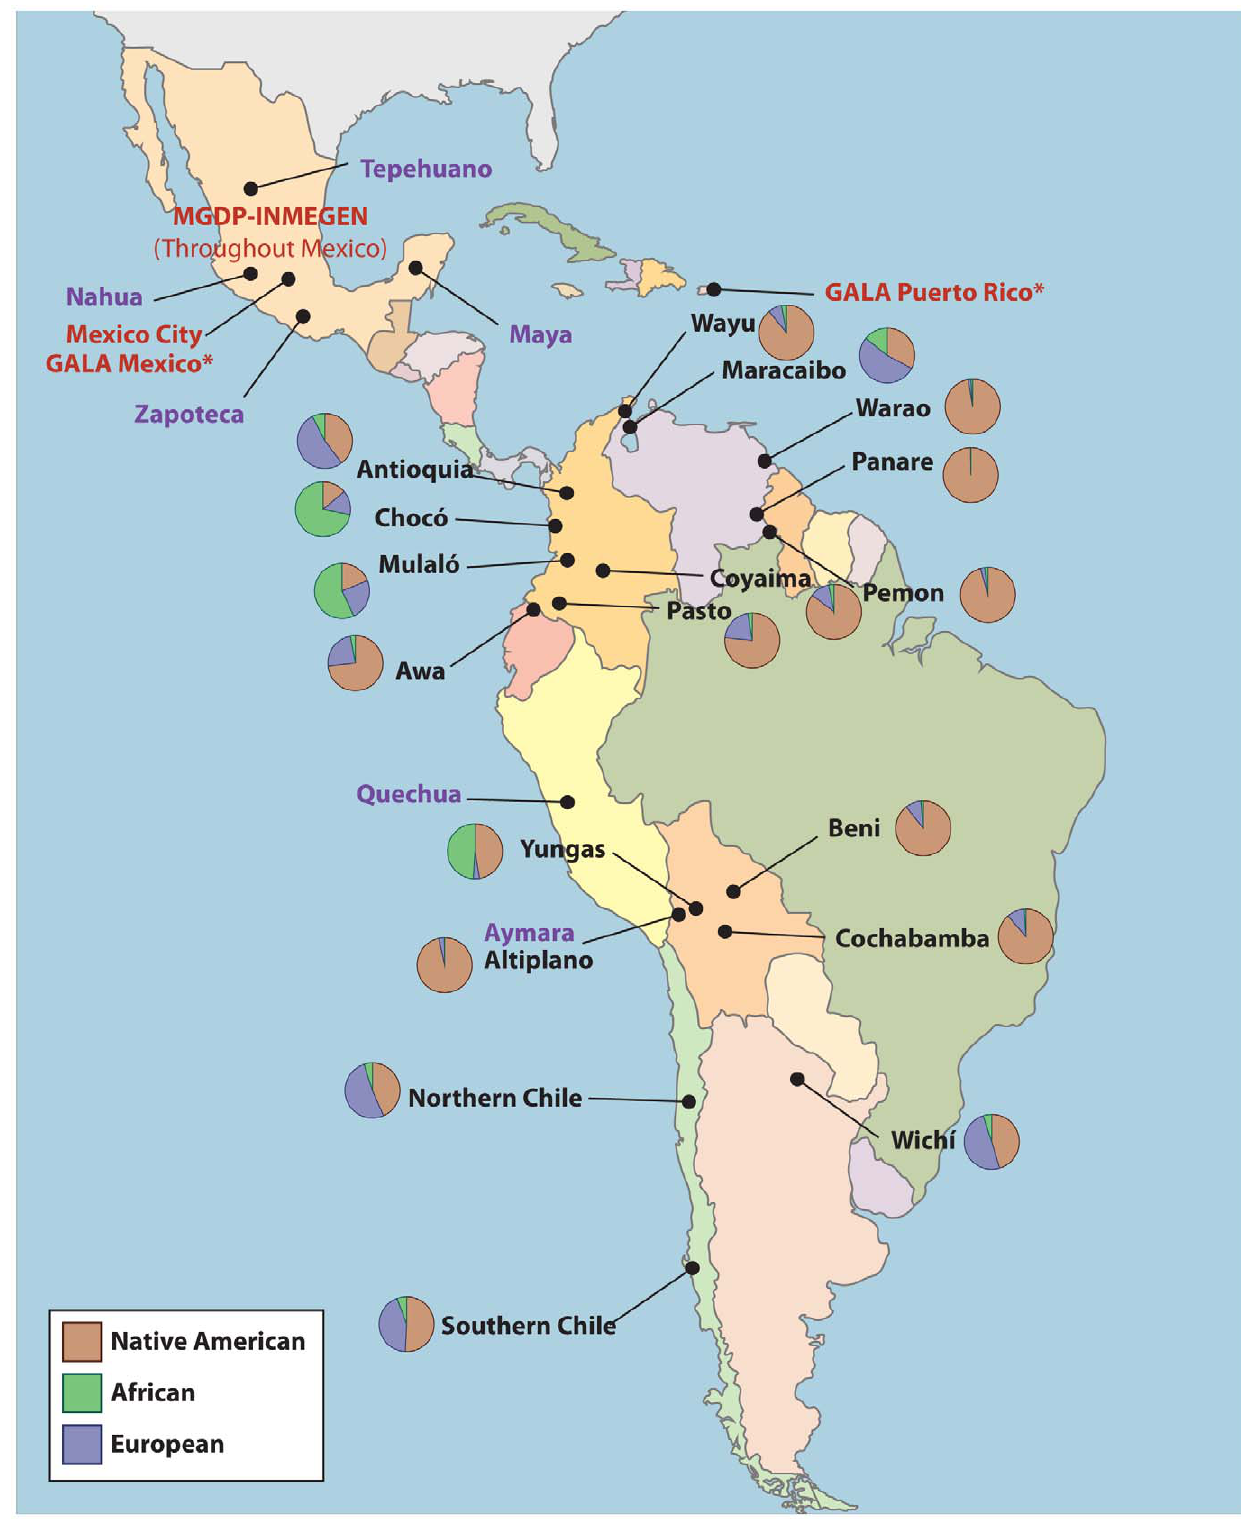
Figure 6. Origin of samples used in this study. Labels in purple correspond to the Native American ancestral populations, labels in red to the validation samples, and labels in black to the 18 populations from throughout the Americas. MGDP-INMEGEN samples were collected throughout Mexico (see Figure S1). GALA Mexico samples were also collected in the San Francisco Bay Area, CA. GALA Puerto Rico samples were also collected in New York, NY.